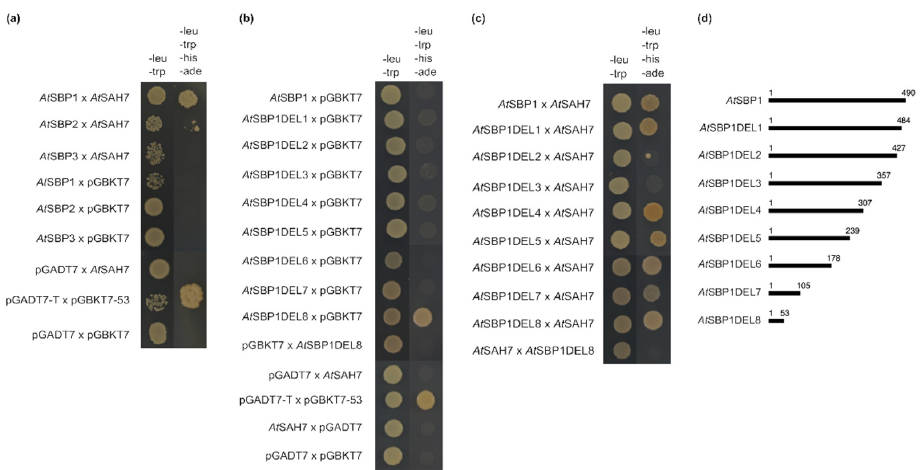
Figure 4 . Yeast two-hybrid assay. ( a ) At SAH7 in vivo interactions with At SBPs. At SAH7 interacts only with At SBP1. ( b – d ) At SBP1 deletions examined for physical interaction with At SAH7. ( b ) Controls used for the deletion analysis. ( c ) Interaction analysis of At SBP1DELs with At SAH7. ( d ) Schematic presentation of At SBP1 truncations used. The first 53aa are important for the aforementioned interaction. To exclude false positives proper controls were used, including pGADT7 × pGBKT7 as a negative control and pGADT7-T × pGBKT7-53 as a positive control.